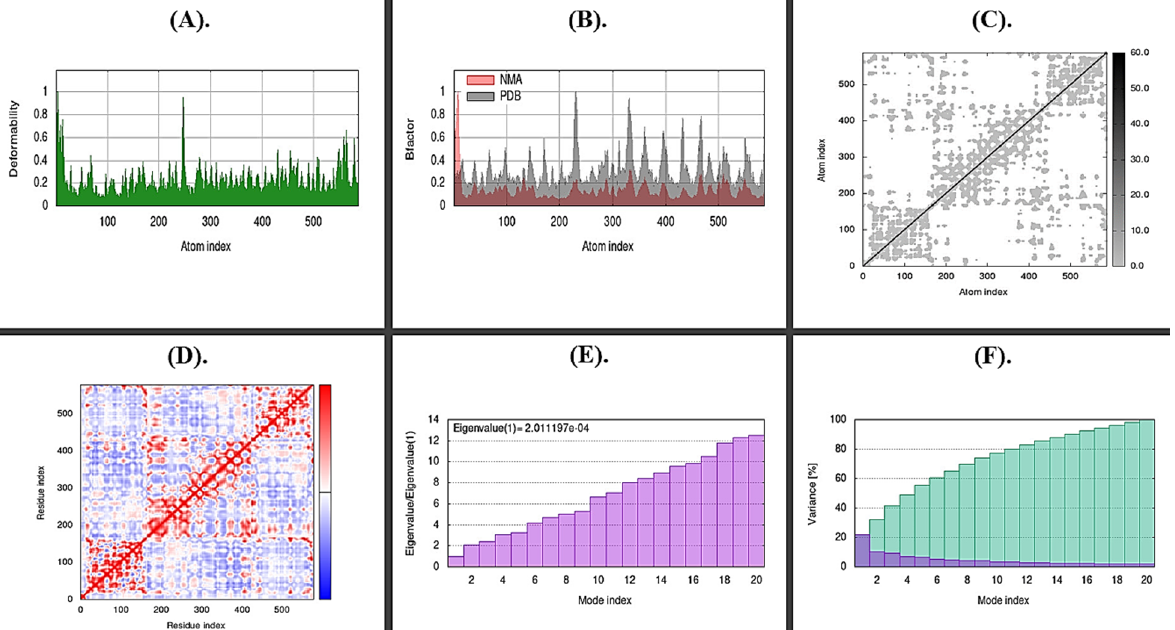
Figure 13. shows a simulation of molecular dynamics of the best docked complex of streptin with spvB. ( A ) Deformability of the complex; ( B ) B-Factor graph, the plot indicates a comparative PDB plot, but there are no validated structures of our molecules on PDB; ( C ) Elastic Network (Grey matter indicates stiffer region); ( D ) Covariance Map: correlated (red), uncorrelated (white), or anti-correlated (blue) motions; ( E ) The eigenvalue plot illustrates the minimum energy required to deform the complex; ( F ) Variance individual variance (purple) and cumulative variance